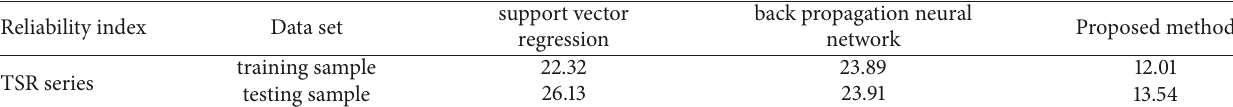
Table 4: MAPE of proposed method and referenced method for lower-phase model based on weekend data (%).